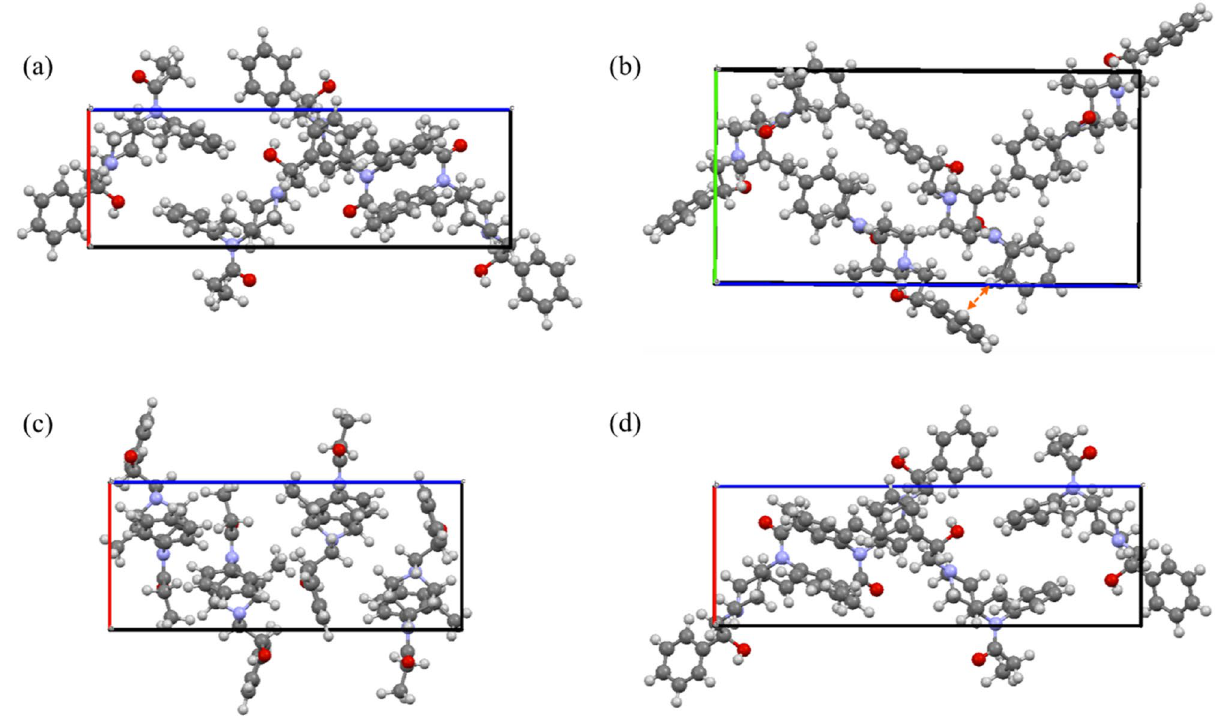
Figure 4. Crystal packing of ohmefentanyl stereoisomers ( a ) cis -( 2R , 3R , 4S ) viewed along with b-axis, ( b ) cis - ( 2R , 3R , 4S ) along with a-axis, ( c ) trans -( 2S , 3R , 4R ) along with b-axis, and ( d ) cis -( 2S , 3R , 4R ) viewed along with b-axis. Carbon, hydrogen, nitrogen, and oxygen atoms are depicted as grey, white, light purple, and red spheres,